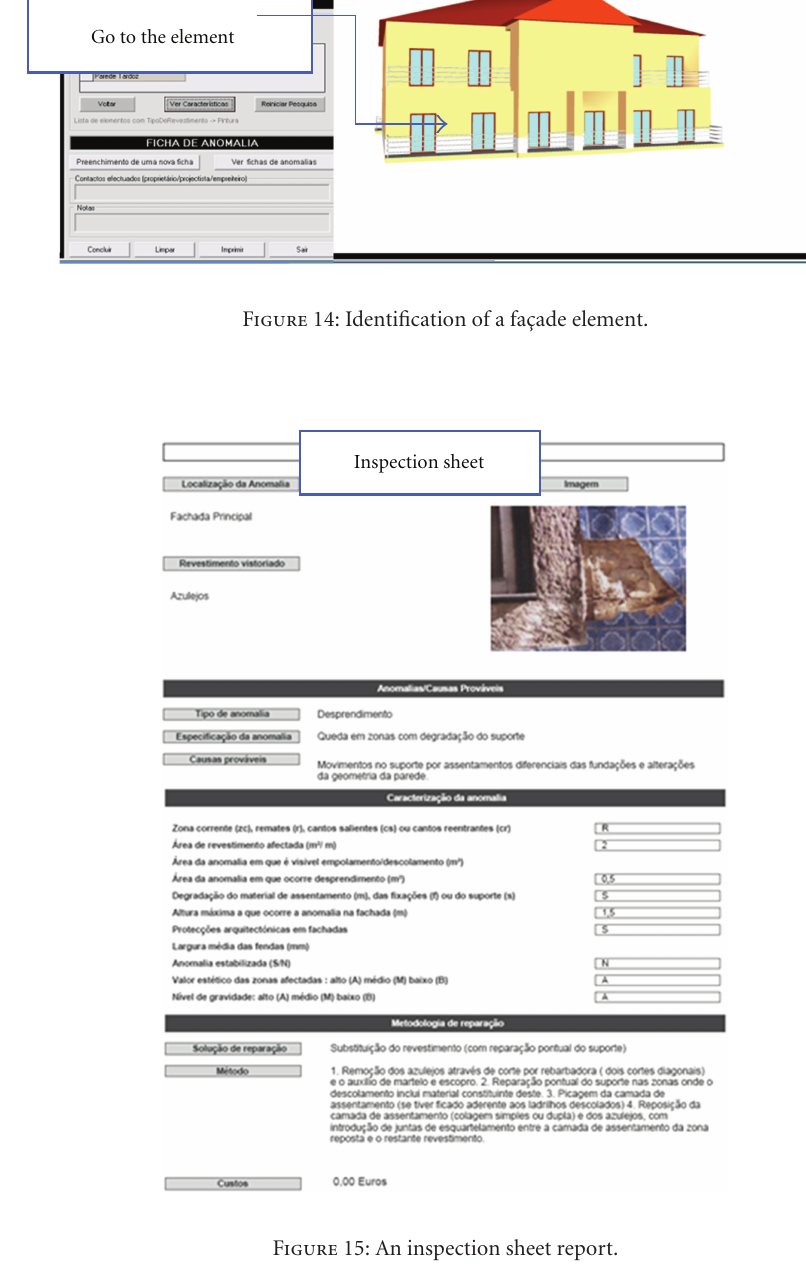
Figure 15: An inspection sheet